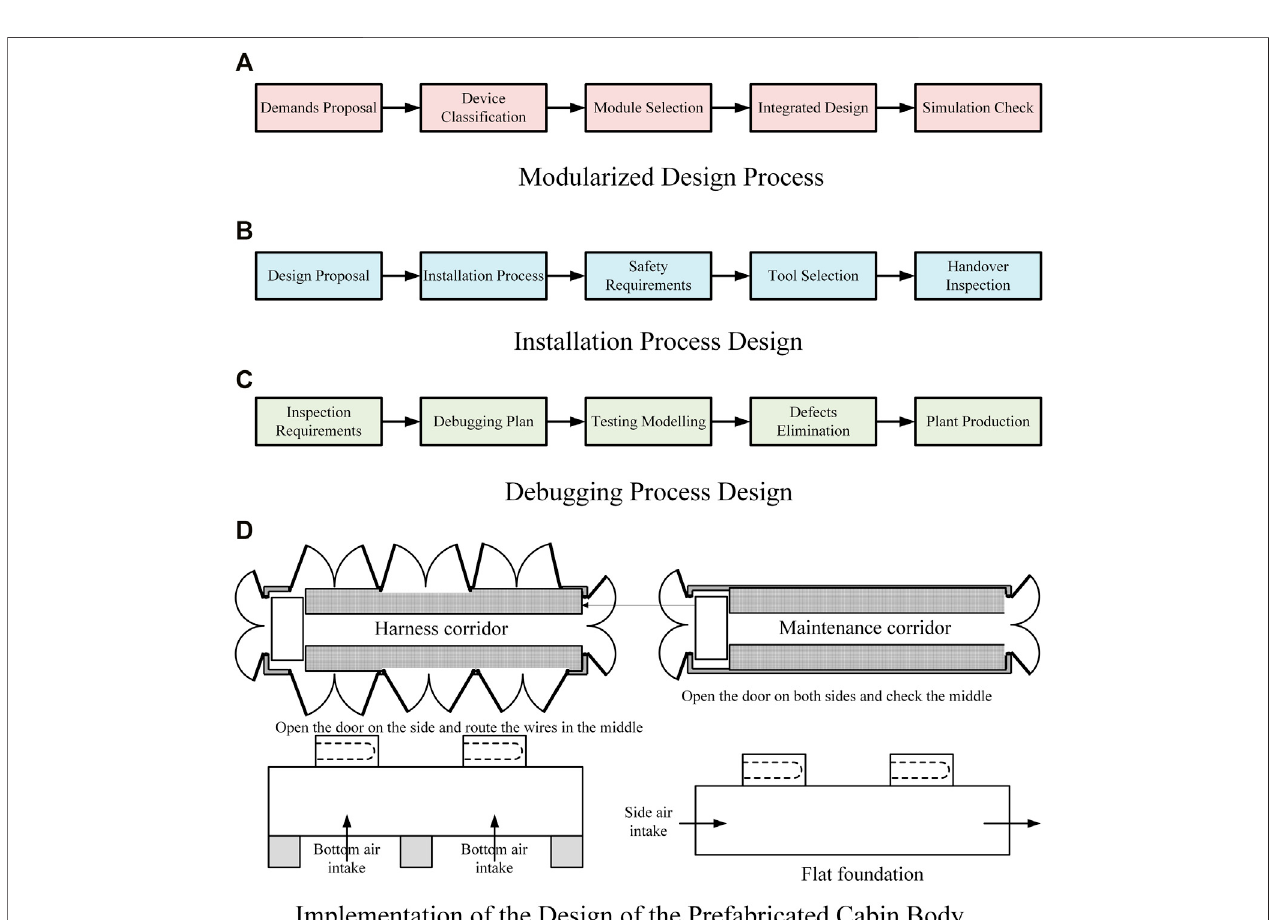
FIGURE 9 | Schematic diagram of the safety design of cabin-type energy storage system.